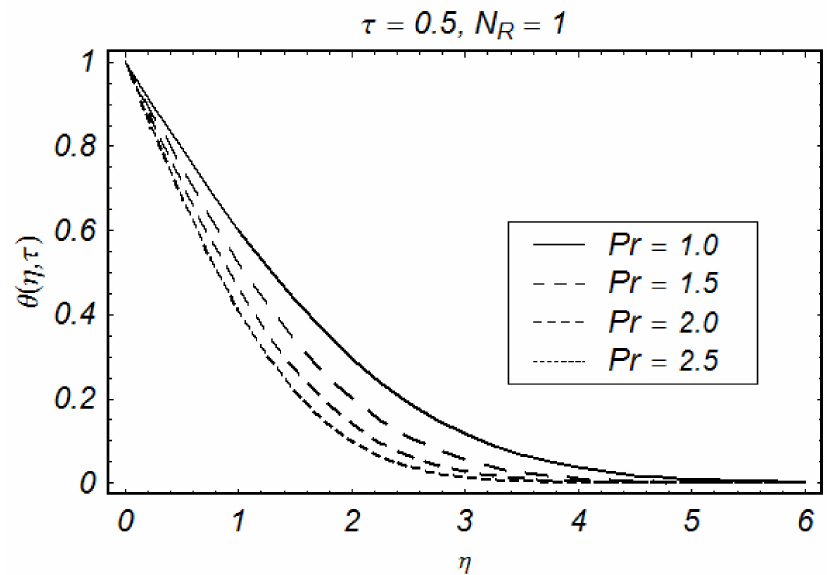
Figure 11. Indication of Pr on temperature profile.